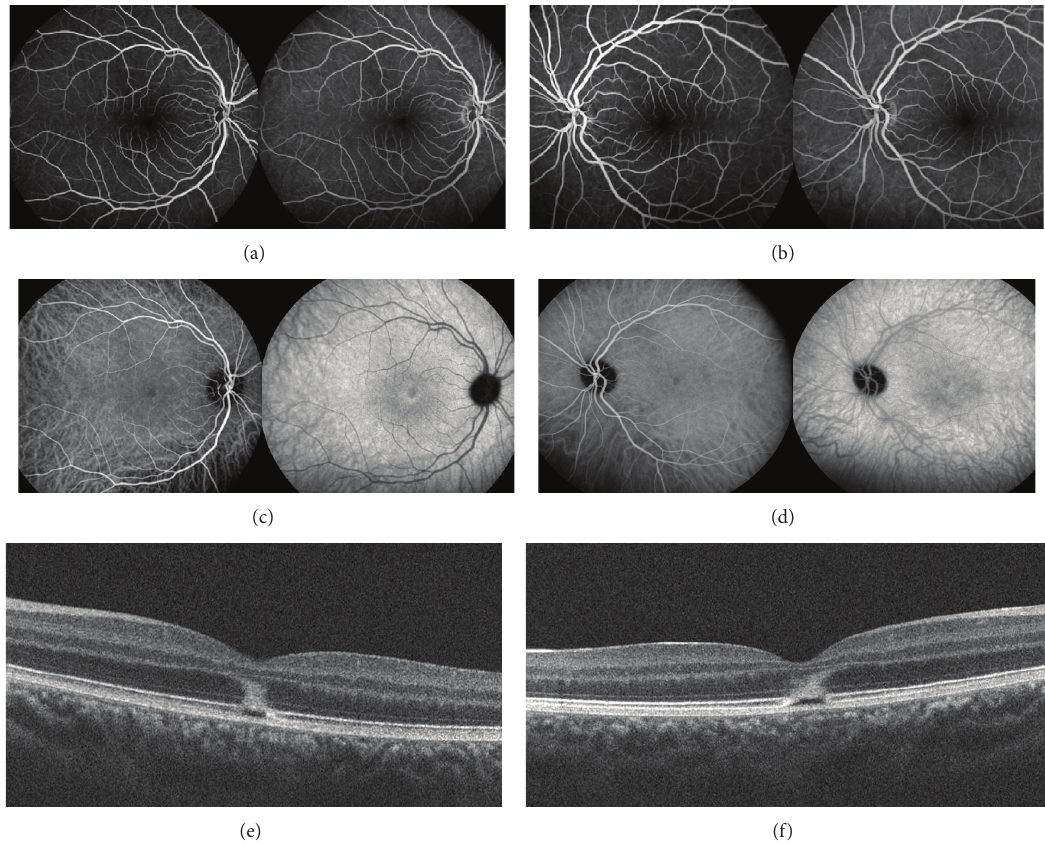
Figure 1: Patient 1. (a), (c), (e): Right eye. (b), (d), (f) Left eye. (a), (b). Fluorescein angiography (2 and 5 minutes), at the initial visit, showing no hyperfluorescence. (c), (d). Indocyanine green angiography (5 and 18 minutes), at the initial visit, showing a hyperfluorescent halo in the macular area. (e), (f) Spectral-domain optical coherence tomography (B-scan), at the initial visit, showing disruptions of the IS/OS junction and the RPE inner band. There is a large hyperreflective lesion involving the external nuclear